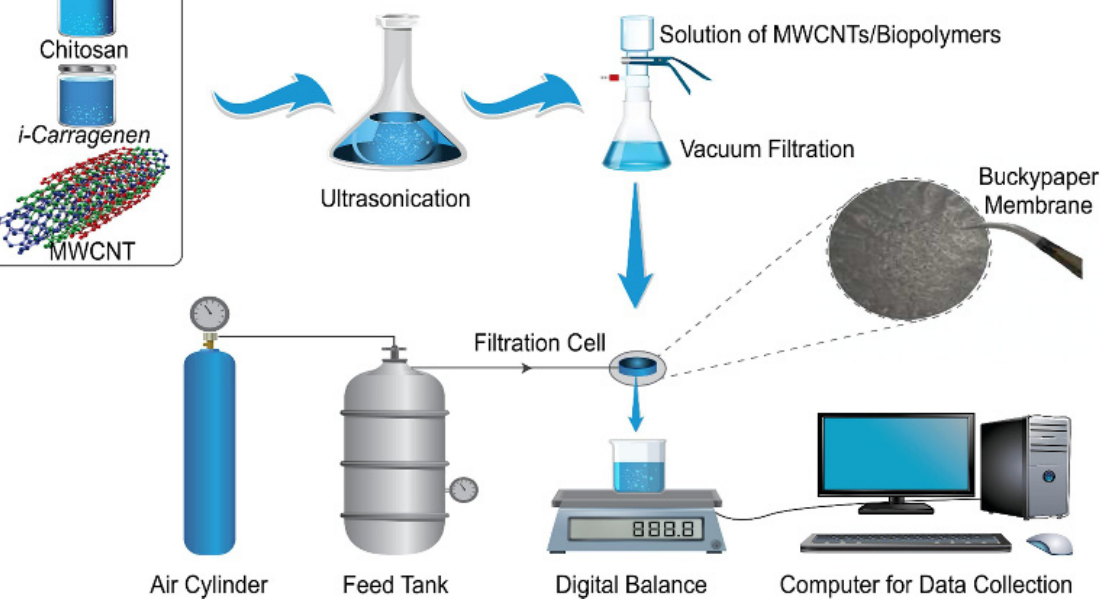
Figure 10. Preparation process of chitosan/carrageenan gum/carbon nanotube composite membrane